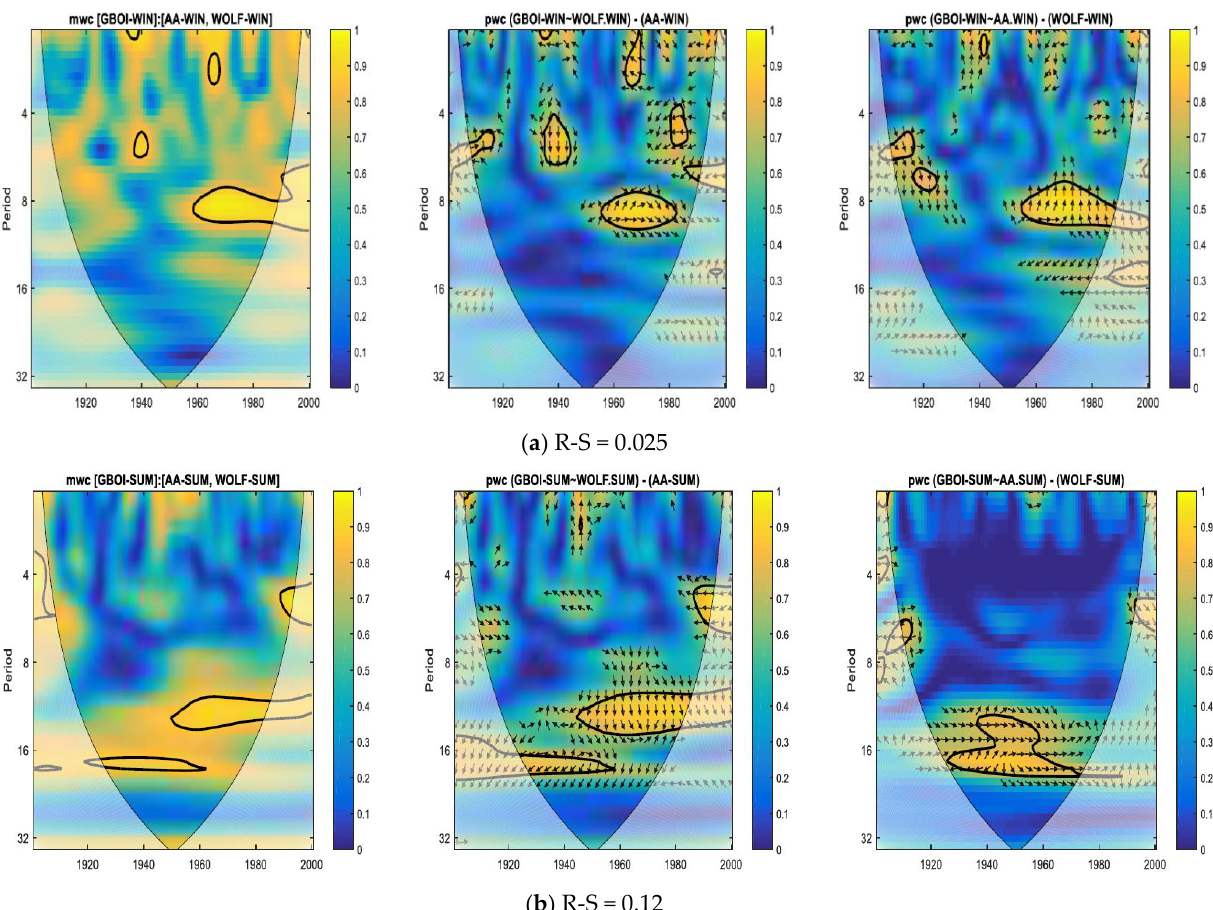
Figure 3. ( a ) Multiple wavelet coherence ( mwc ) between GBOI and the two predictors aa (AA) and Wolf Number (WOLF), during winter ( left panel ); partial wavelet coherence ( pwc ) between GBOI and Wolf number, excluding the effect of aa ( middle panel ), and pwc between GBOI and aa , excluding the effect of Wolf number ( right panel ). ( b ) Same as ( a ) but for summer. The years (1901–2000) are represented on the